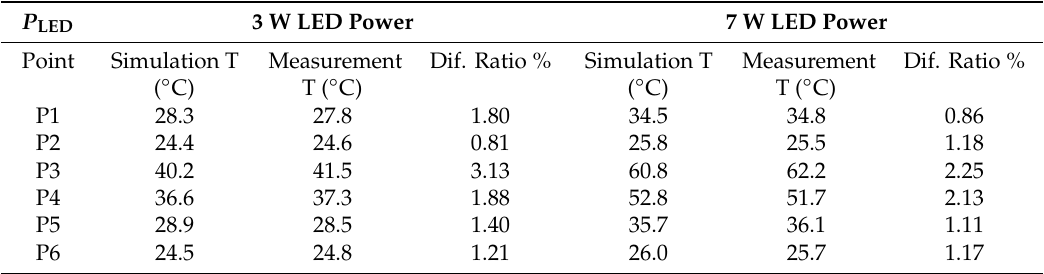
Table 5. Comparison of the computed and the measured data on the top copper surface for the plane cover, 9 mm channel height and 0.01 kg / s mass flow